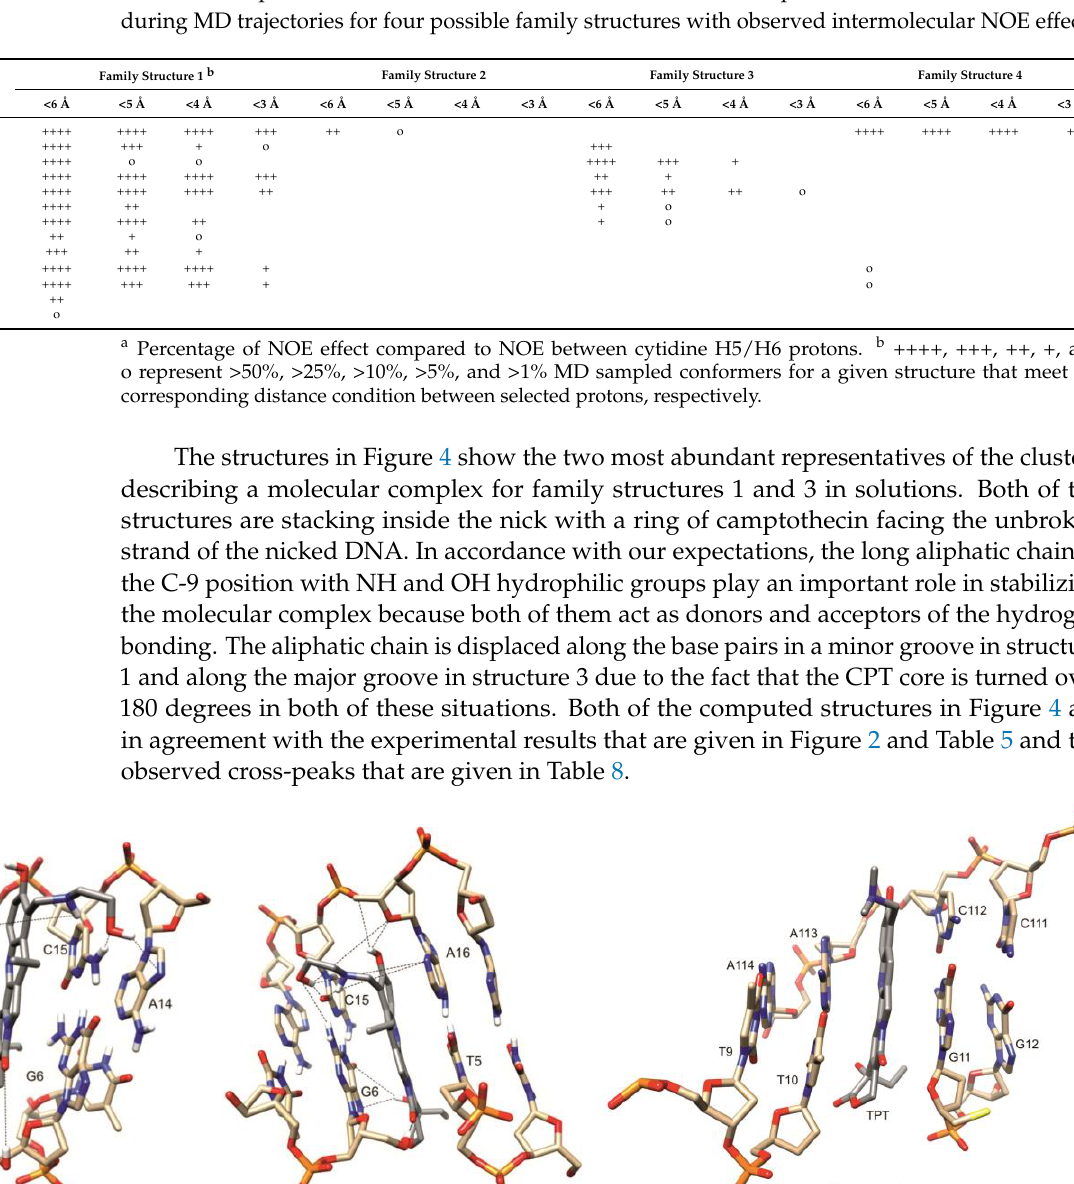
Table 8. Comparison of measured distance statistics for selected protons in conformers recorded during MD trajectories for four possible family structures with observed intermolecular NOE effects.